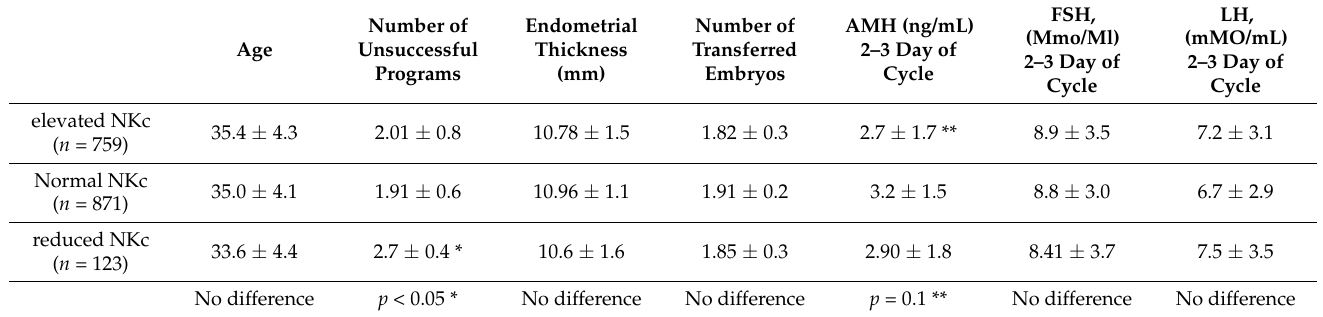
Table 1. Clinical anamnesis and hormonal characteristic of randomized groups. p < 0.05 * compared to “Normal NKc: group ** p = 0.1 compared to “Normal NKc: